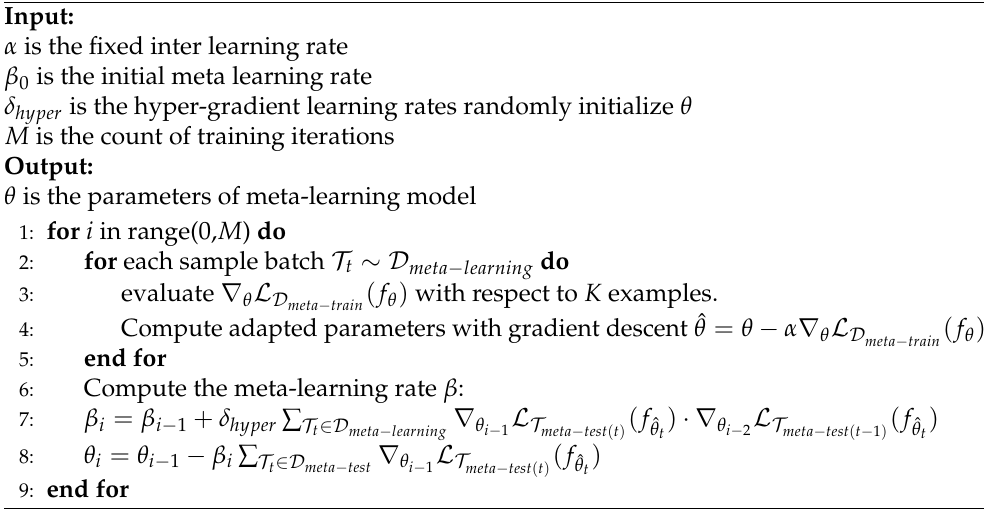
Algorithm 1 Dynamic- β